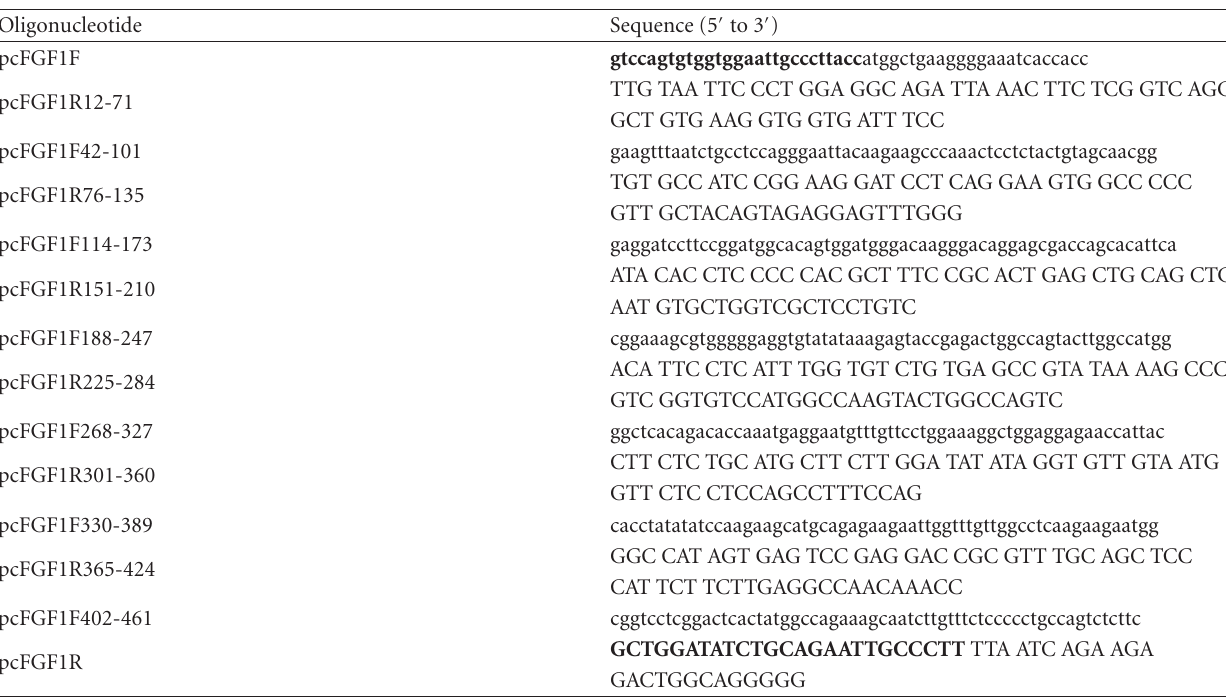
Table 1: List of